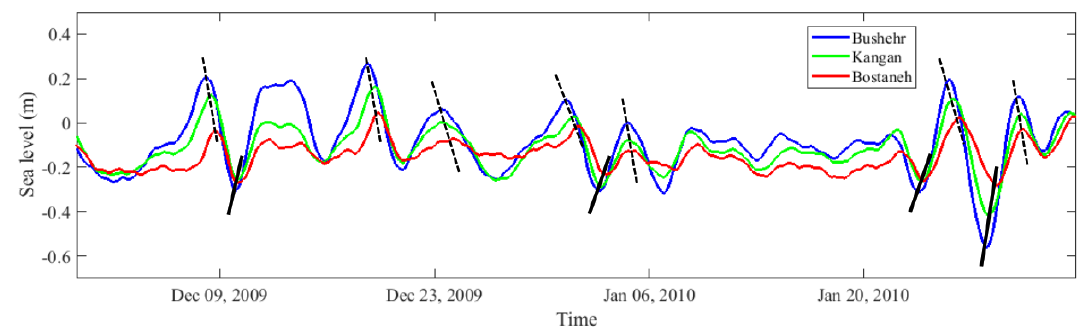
Figure 15. Low ‐ pass ‐ filtered sea ‐ level records at Bushehr (Blue), Kangan (Green), and Bostaneh (Red) stations. The dashed and solid black lines show the sequences of high and low waters, respectively.